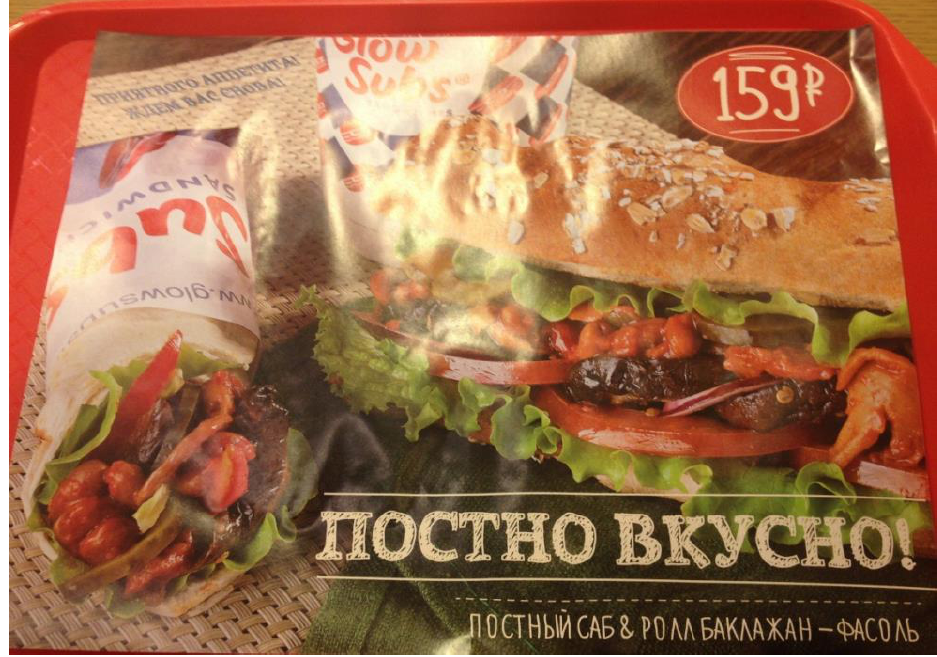
Figure 2. “Lenten Tasty!”. Tray liner, advertizing Lenten offers.